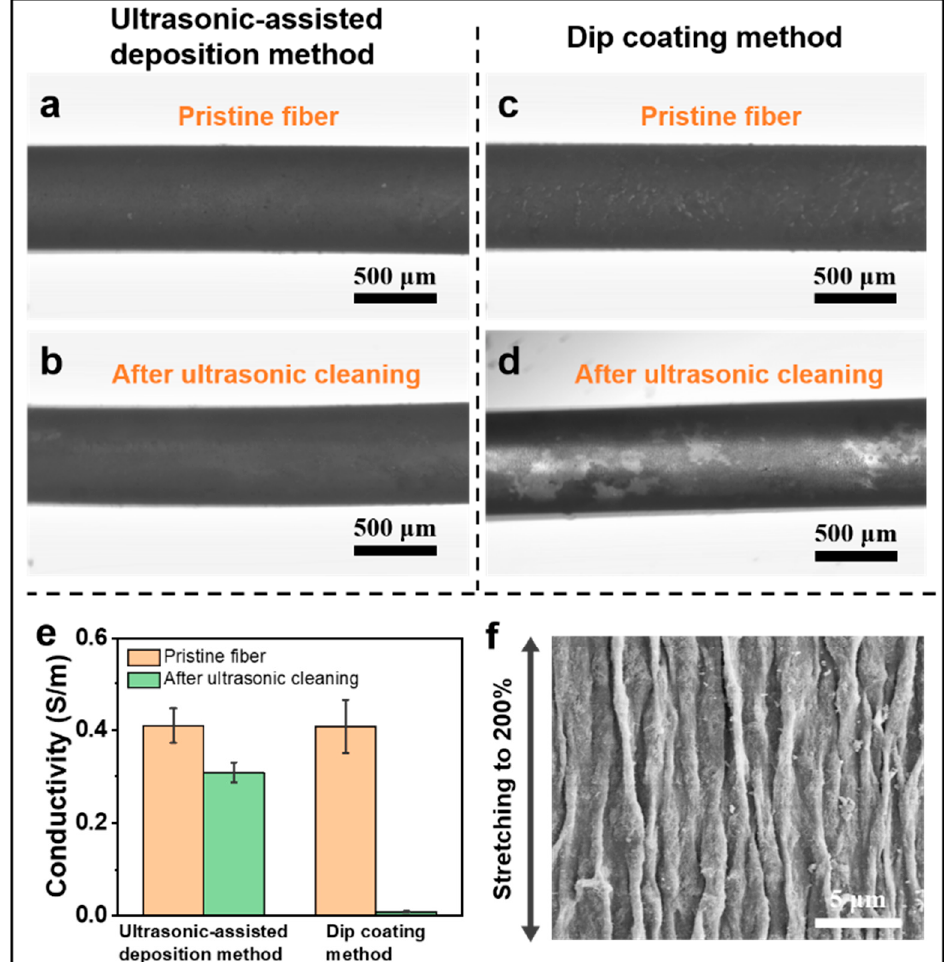
Figure 3. Optical photographs of CNTs@PDMS fibers fabricated by ultrasonic-assisted deposition method ( a , b ) and dip-coating method ( c , d ) before and after ultrasonic cleaning. ( e ) Conductivity variation of CNTs@PDMS fibers prepared from different methods before and after ultrasonic cleaning for 5 min. ( f ) SEM image of CNTs@PDMS fiber under 200% strain.